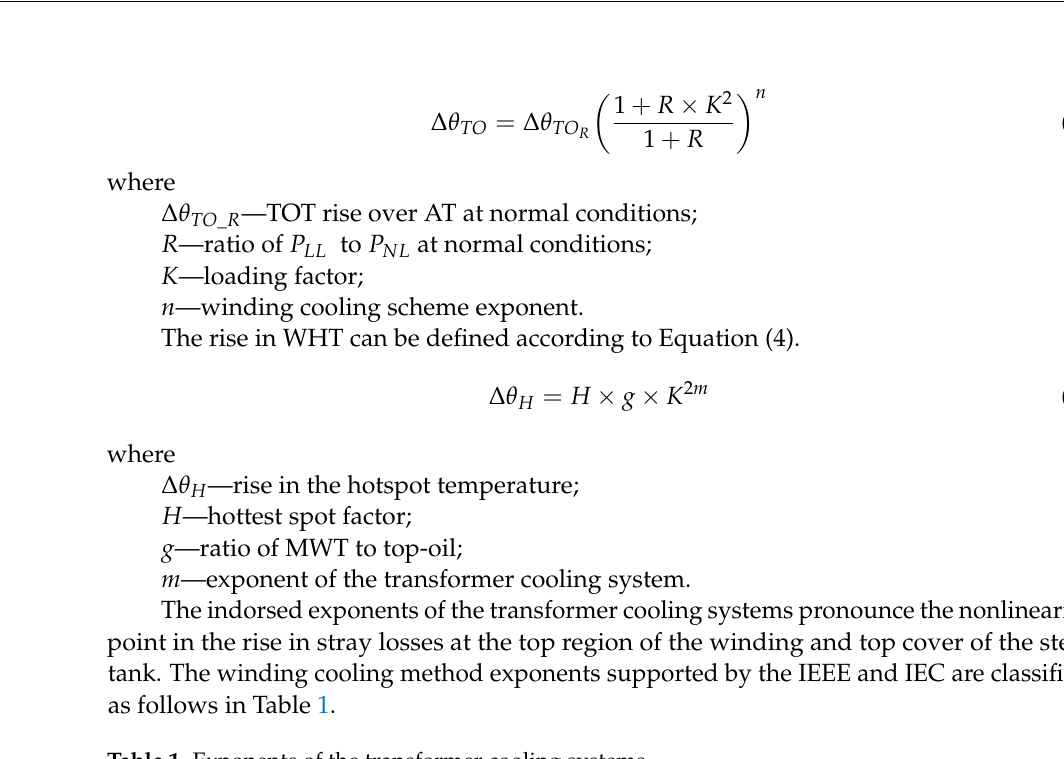
Table 1. Exponents of the transformer cooling